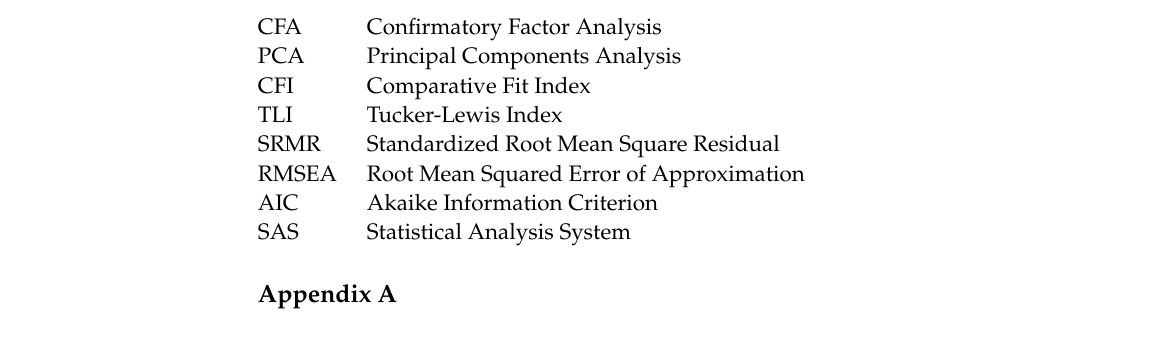
Table A1. Original Brief COPE